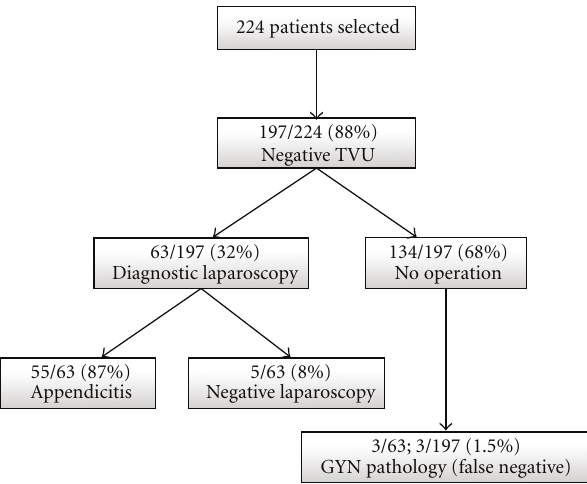
Figure 2: Patients with negative transvaginal ultrasound